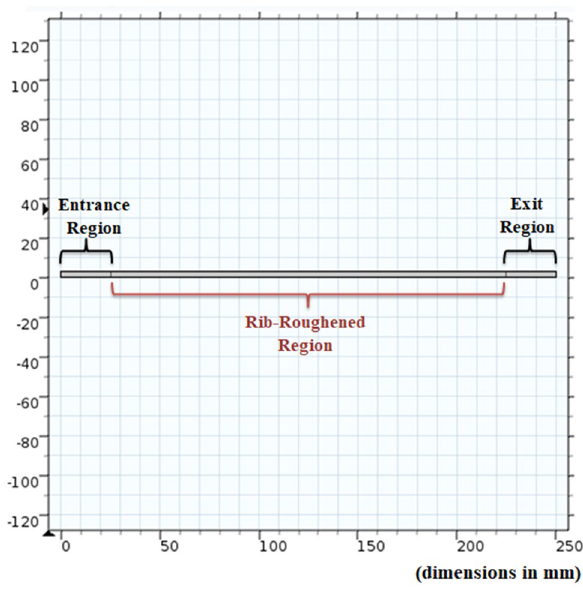
Fig. 4 CFD Simulation geometry for effectiveness analysis of the calibration process